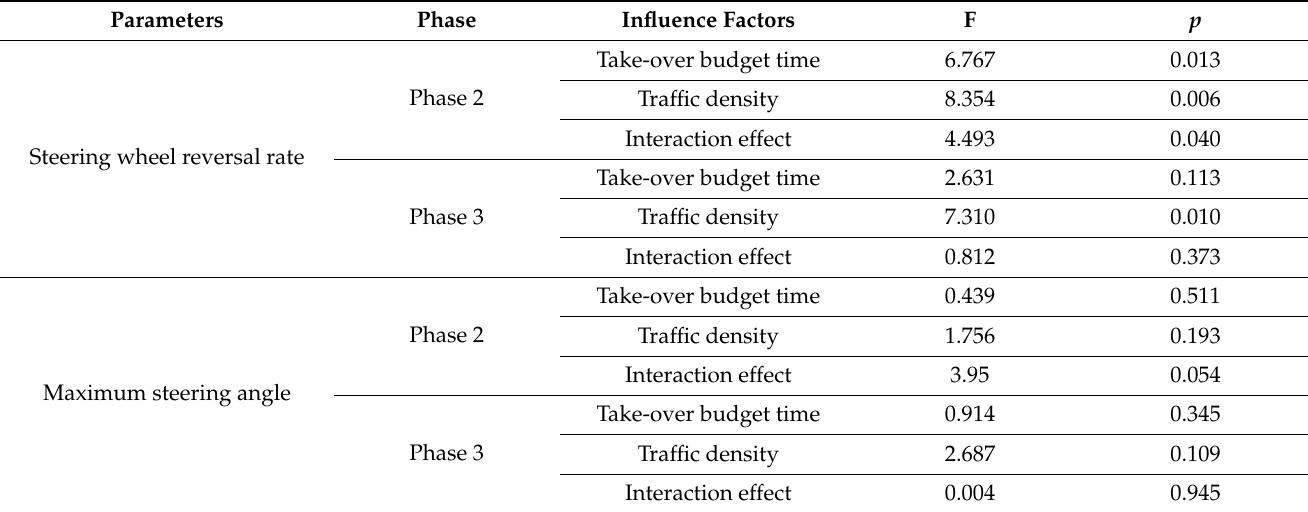
Table 2. Influence of take-over budget time and traffic density on lateral operation